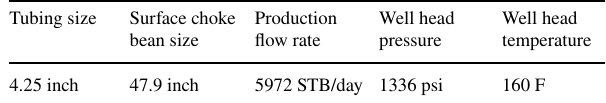
Table 14 Results of asphaltene deposition simulation